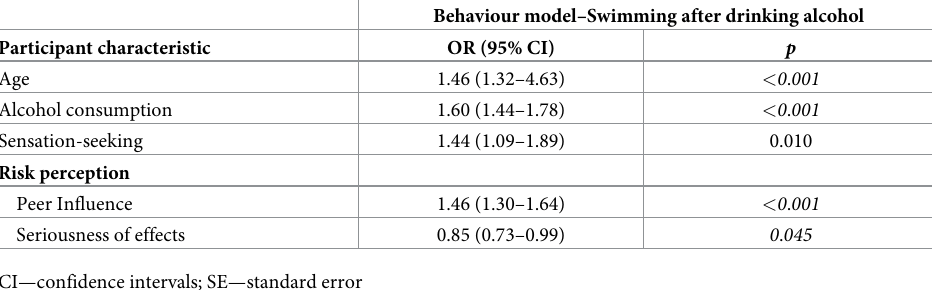
Table 3. Predictor coefficients for the logistic regression model predicting participation in swimming after drink- ing alcohol. Behaviour model–Swimming after drinking